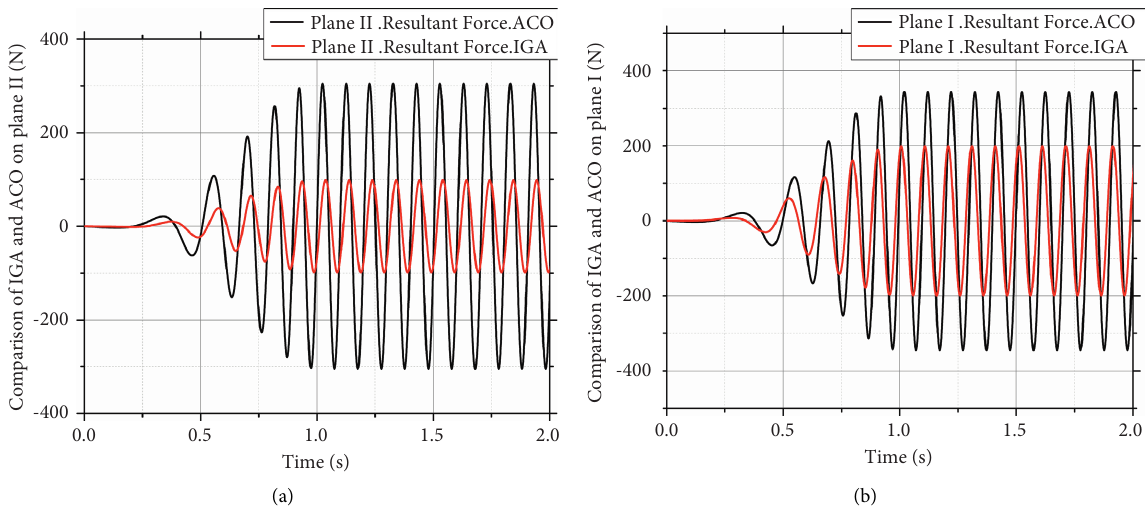
Figure 11: Comparison of simulation results between IGA and ACO in ADAMS. (a) Comparison of IGA and ACO on plane Ι . (b) Comparison of IGA and ACO on plane ΙΙ